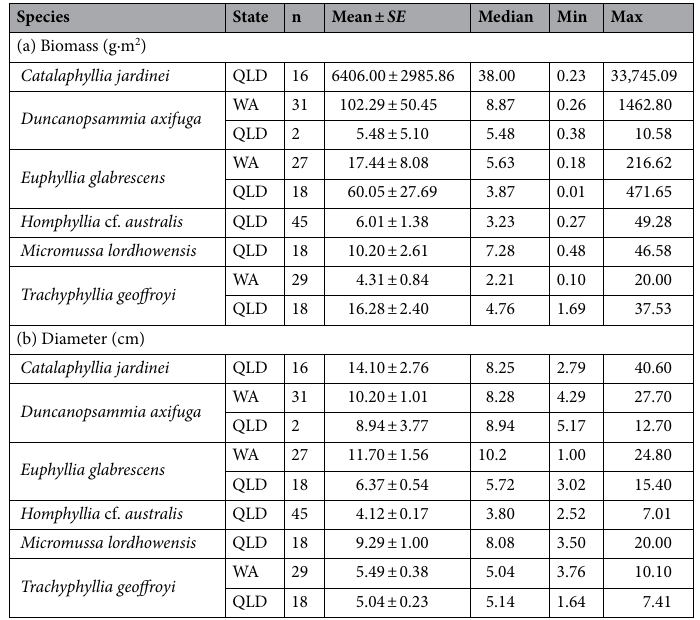
Table 2. The (a) average transect biomass per unit area (g m 2 ) and (b) maximum diameter (cm) of corals recorded on transects, including state that the sample was obtained from, number of transects (n), mean ± SE , median, minimum (min) and maximum (max) value, by